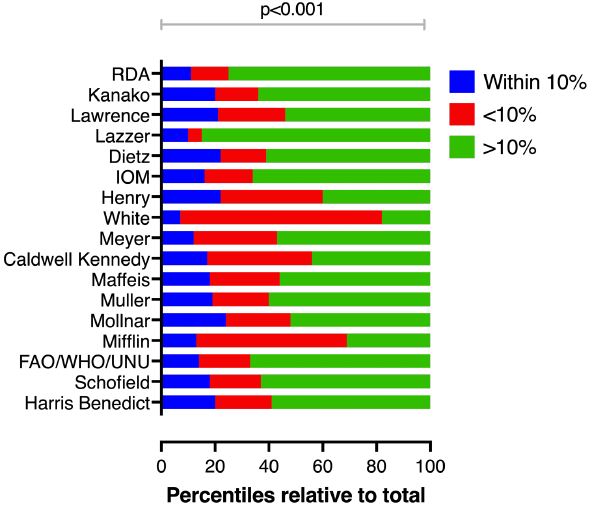
Figure 2. Percentages of estimated resting energy expenditure (eREE) values of an equation within 10% of resting energy expenditure measured by IC (REE IC ) (blue color). Inaccuracy profiles varied from underestimation (red color) to overestimation (green color) of the patient ’ s energy needs. Clin- ically significant percentage error (eREE − REE IC )/ REE IC (%) was considered a difference of ≥ ±10% and it was significantly lower than an expected minimum accuracy of 50%.